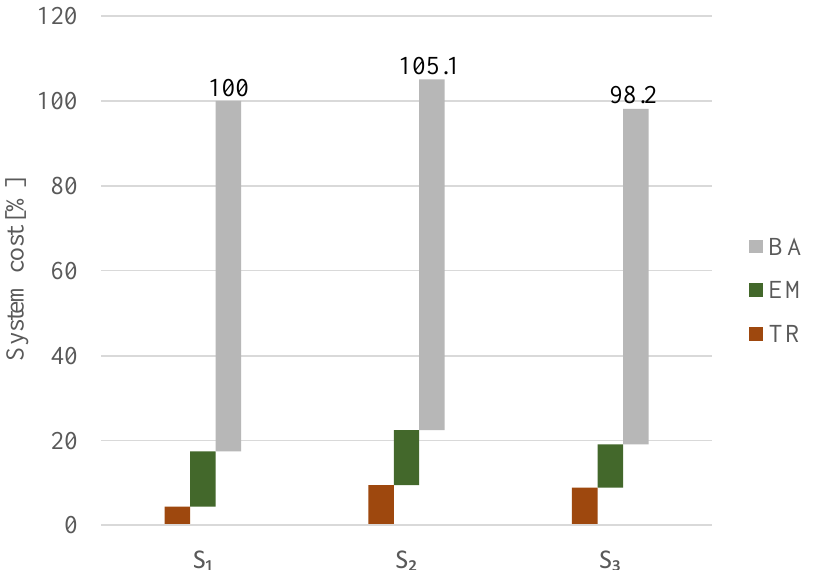
Figure 15. Comparison of normalized system cost between S 1 , S 2 and S 3 , where the EM cost includes the DC-AC inverter.